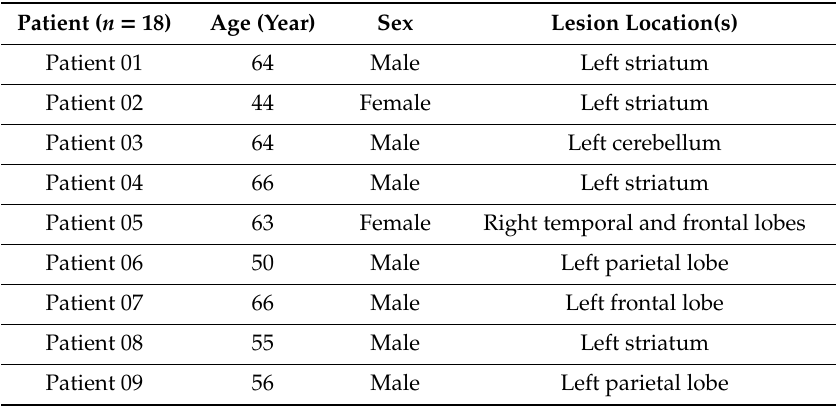
Table 1. Demographic data of each included stroke